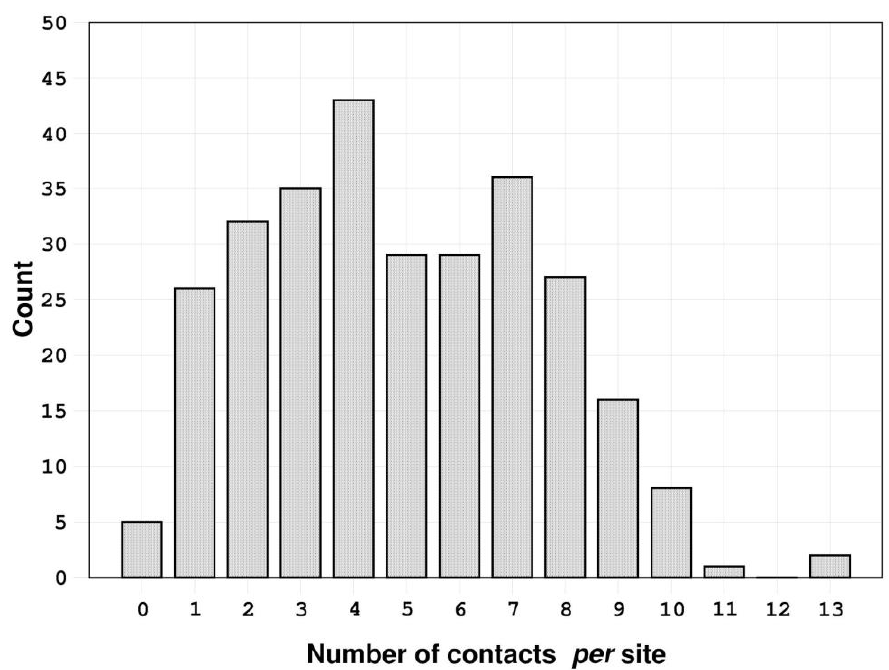
Figure 1. Distribution of the number of contacts per site established by the 289 urea molecules ana- lyzed.